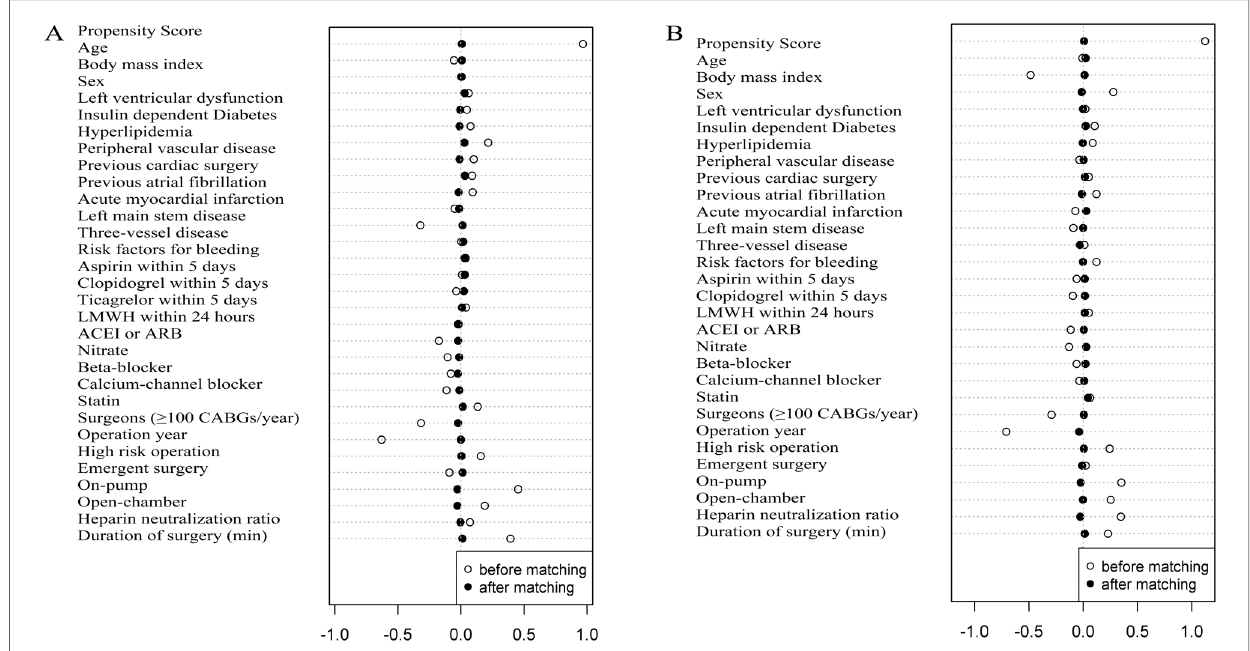
FIGURE 2 ElderlypatientsundergoingCABGsurgerywithorwithoutTAorwithhigh-orlow-doseTAadministrationwerematchedbypropensityscore.( A )PSMwasusedand wellbalancedinelderlypatientswithorwithoutTAadministration.Thestandardizeddifferencewaslessthan0.1in30variables;( B )elderlypatientswithhigh-dose and low-dose TA administration were matched well by propensity score. The standardized difference was less than 0.1 in all 29 covariates. Insulin-dependent diabetes was de fi ned as the treatment of patients ’ diabetes dependent on insulin therapy. Left ventricular dysfunction was de fi ned as a patient ’ s ejection fraction ≤ 40%. Surgeons who performed more than 100 CABG surgeries per year assigned a value of “ 1 ” , and surgeons who performed less than 100 CABG surgeries per year were assigned a value of “ 0 ” . The risk factors for bleeding were age older than 70 years, female sex, low-molecular-weight heparin or an antiplatelet drug less than 5 days before surgery, renal impairment (estimated glomerular fi ltrationrate, <60 ml per minute), and insulin-dependent diabetes.